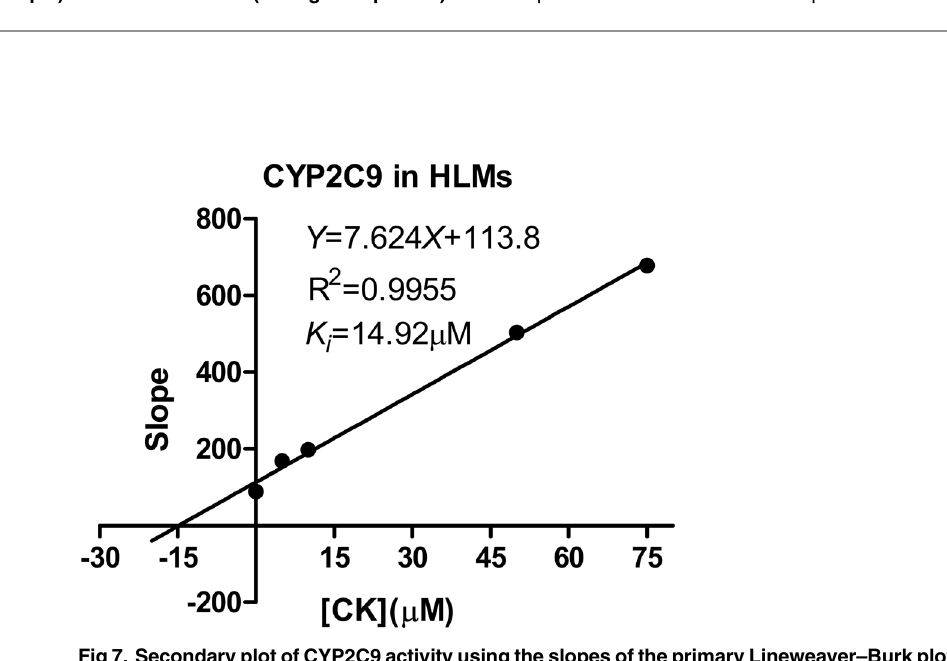
Fig 7. Secondary plot of CYP2C9 activity using the slopes of the primary Lineweaver – Burk plots versus concentrations of CK. Note: Nonlinear regression analysis of the tolbutamide 4-hydroxylation versus the substrate concentration was performed to obtain the K i values. Each point represents the mean of triplicate